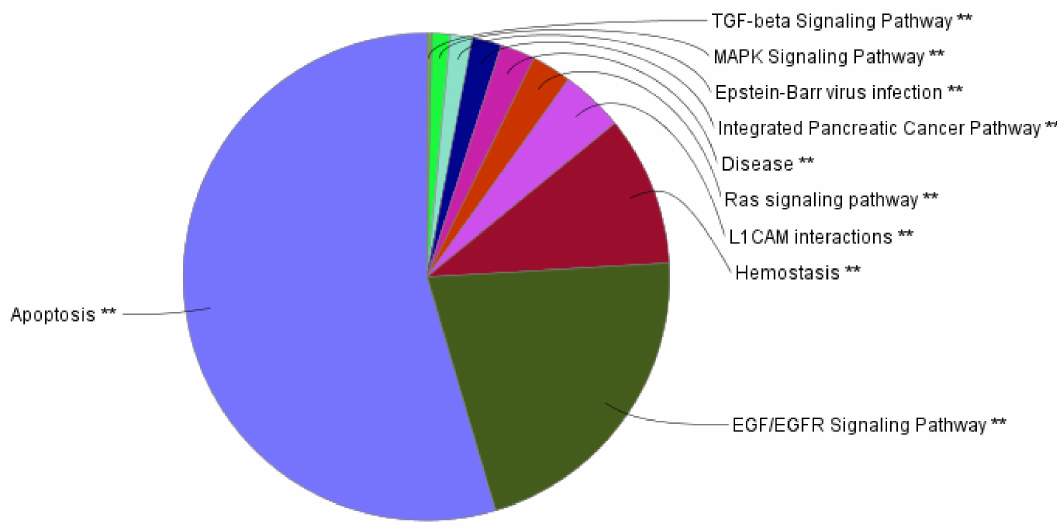
Figure 6. Pie chart representation of the preponderance of highly enriched processes and pathways in the CD based on an analysis of 365 densely connected cluster genes found in CD. For the complete list of all the enriched pathways of the connected cluster genes in CD please see Supplementary Table S1. ** indicates significant GO terms and pathways with p-value <